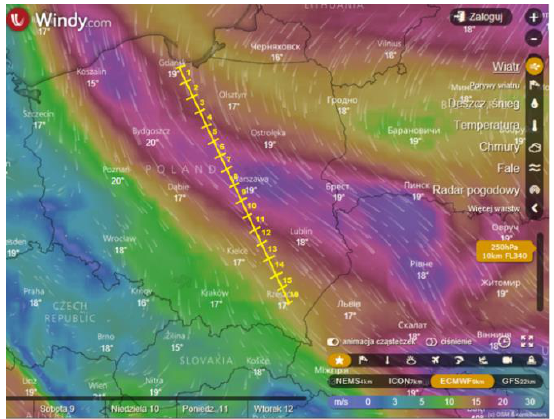
Fig. 2. Map of meteorological conditions (wind direction and velocity) at the time of conducted research on the trajectory of Gulfstream between Gdansk and Rzeszow at the altitude of 10,000 m (based on